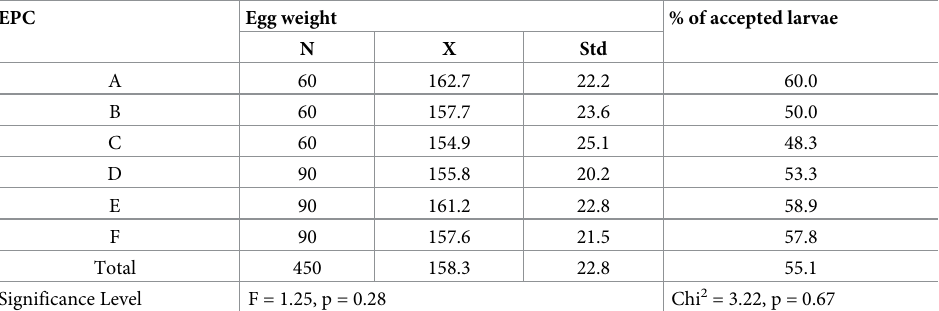
Table 2. Mean and standard deviation of egg weight per EPC (egg producing queen) and acceptance of the larvae of these EPQ for queen rearing. EPC Egg